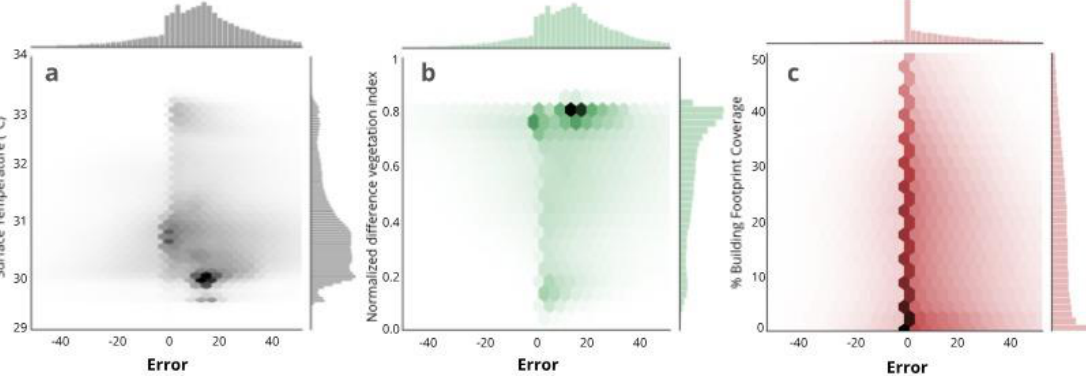
Figure 8. Distribution of error (deviation by % when compared to high-resolution derived data) across all cities by ( a ) surface temperature, ( b ) Normalized Difference Vegetation Index, and ( c ) building footprint coverage gradients.